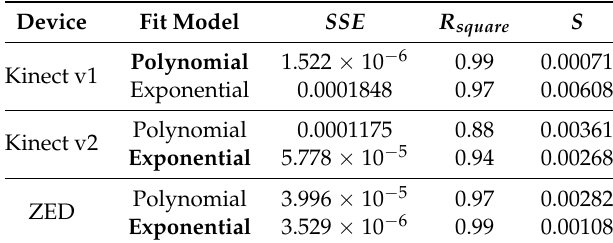
Table 2. Goodness-of-fit statistics analysis.